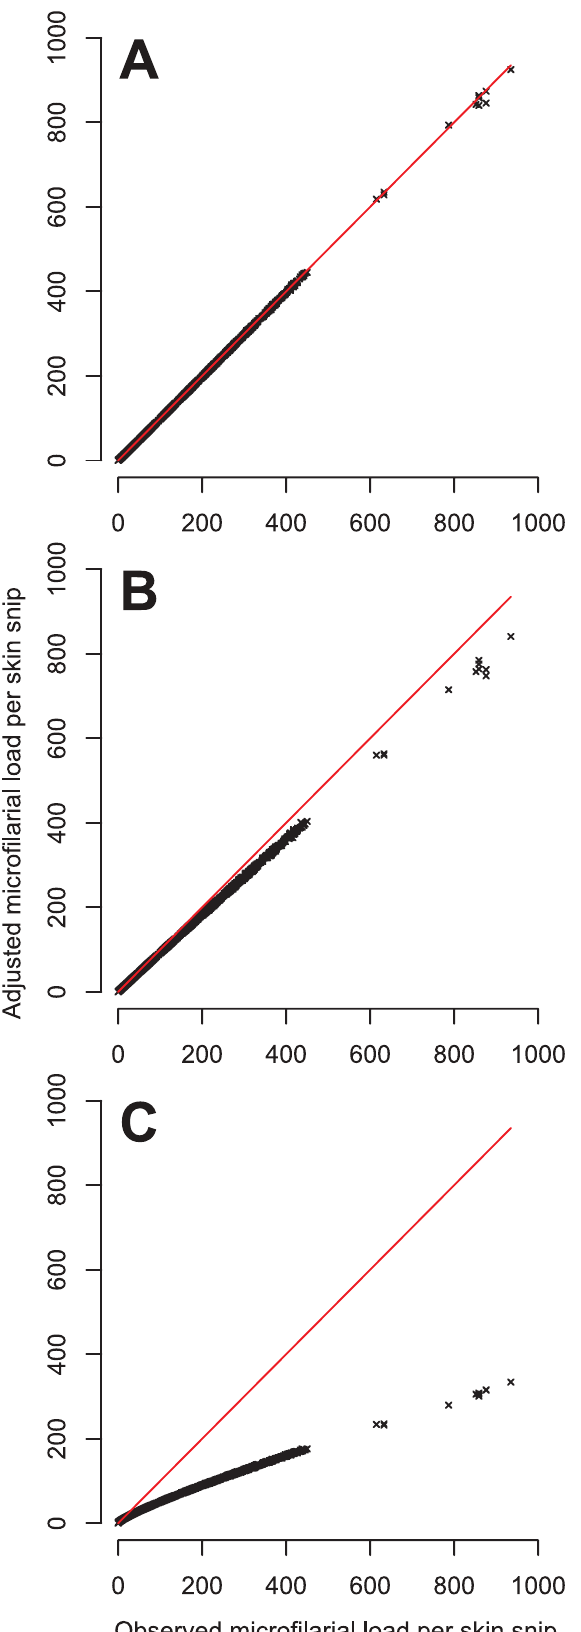
Figure 3. Measurement error-adjusted microfilarial loads plotted against their observed values. Each panel corresponds to an adjustment for a different assumed magnitude of measurement error as defined by parameter k of the negative binomial measurement error model (see Measurement Error section in the main text). In panel A, k R ‘ which corresponds to Poisson measurement error. In panel B, k =15 as estimated from published data [43] (see Protocol S3). In panel C, k = 1, which corresponds to an arbitrarily large degree of measurement error. In each panel the solid red line is the diagonal representing perfect agreement between observed and adjusted microfilarial